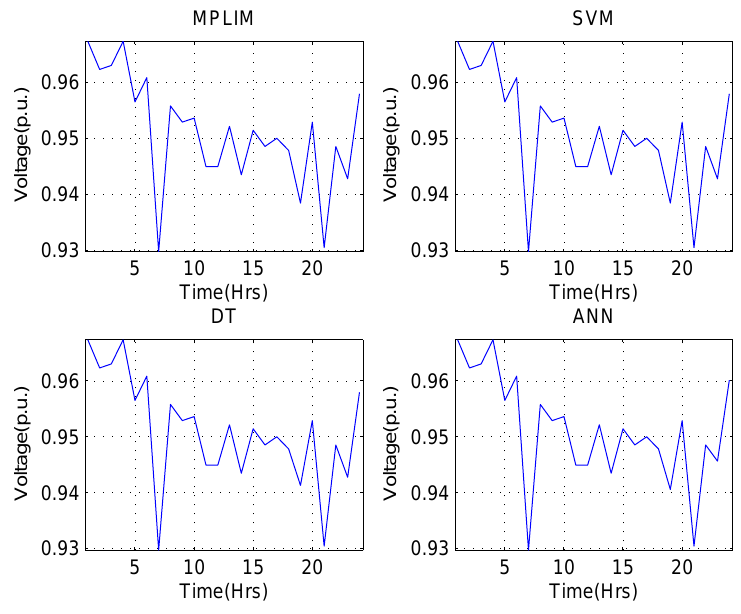
Figure 10. Minimum voltage calculated for 24 h. Table 7. Percentage of hits and AMD by variable for 20% variation in